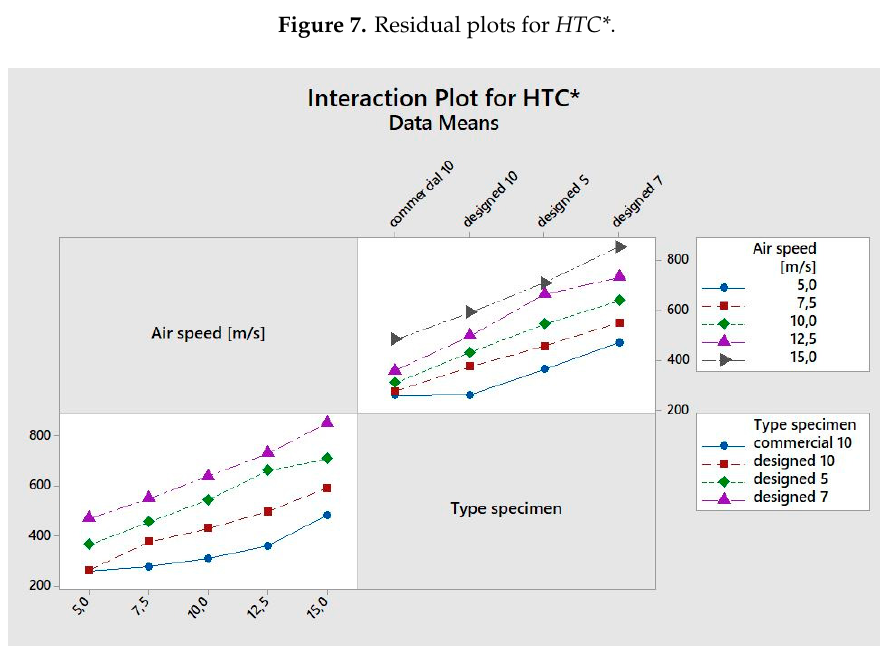
Figure 8. Interaction plot for HTC* .